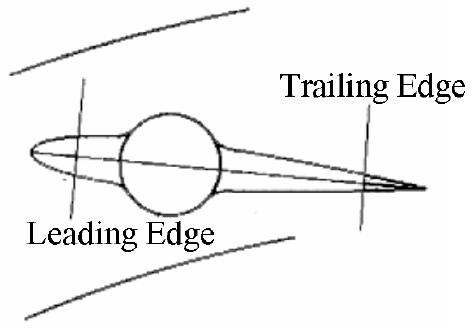
Figure 10. Guide vane measurement position.